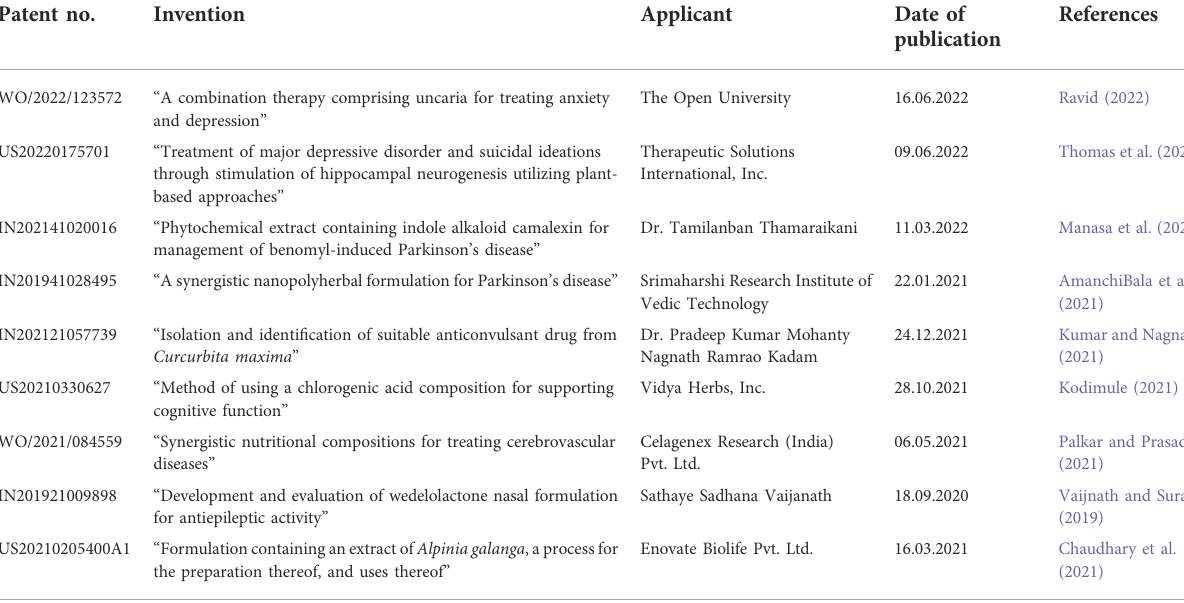
TABLE 4 List of different patents on different phytoconstituents for neurological disorders. Patent